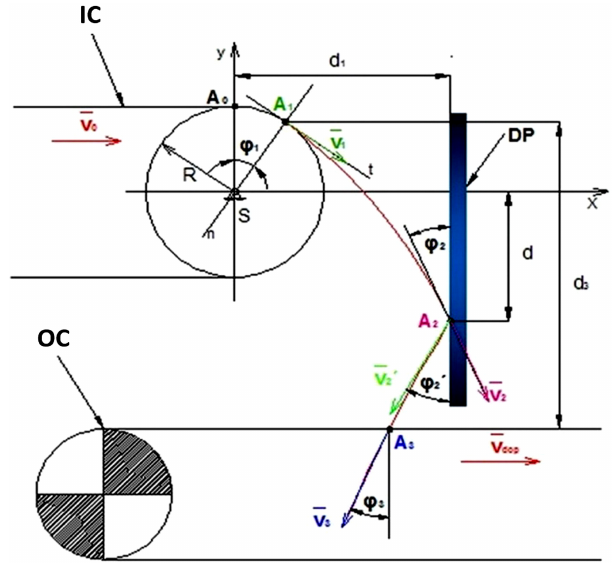
Figure 2. Trajectory of material particle movement during three phases. DP – damping plate; IC – incoming conveyor; OC – outgo- ing